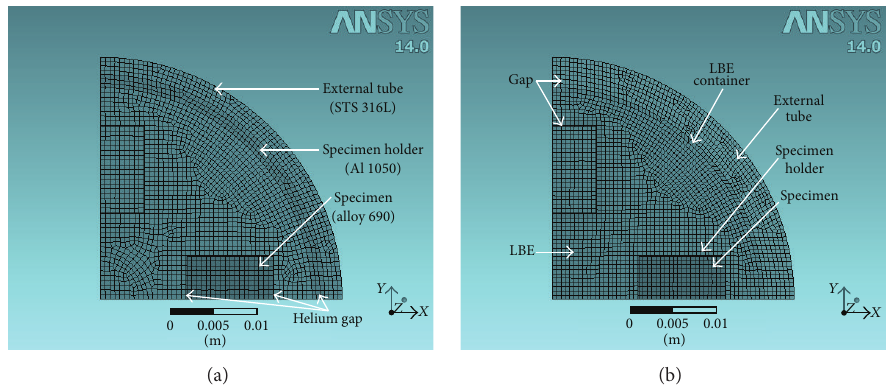
Figure 4: Calculation model ((a) solid thermal media/(b) liquid thermal media).